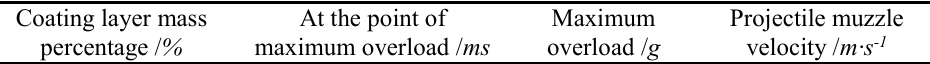
Table 4. Influence of coating layer thickness on the internal ballistic overload value Coating layer